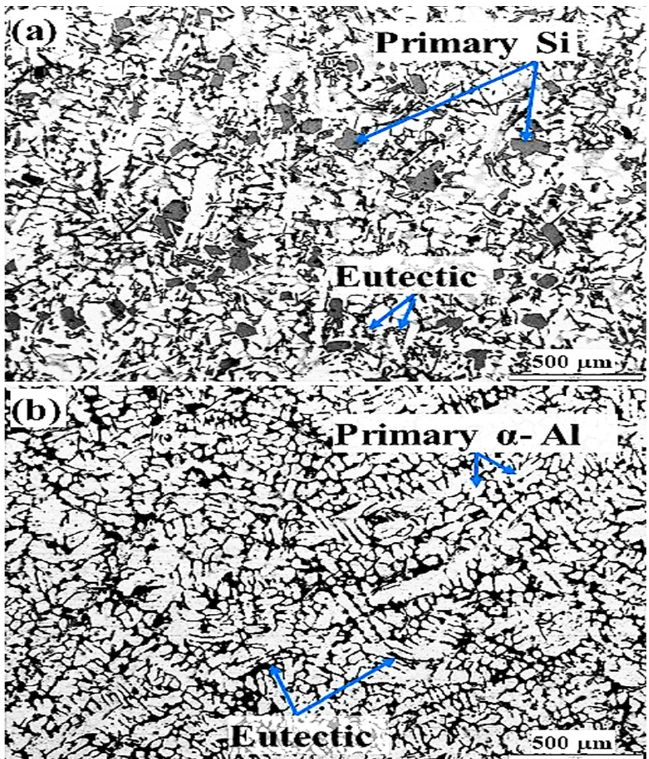
Figure 2. Microstructure of ( a ) Al-18Si and ( b ) Al-7.5Si aluminum alloys.